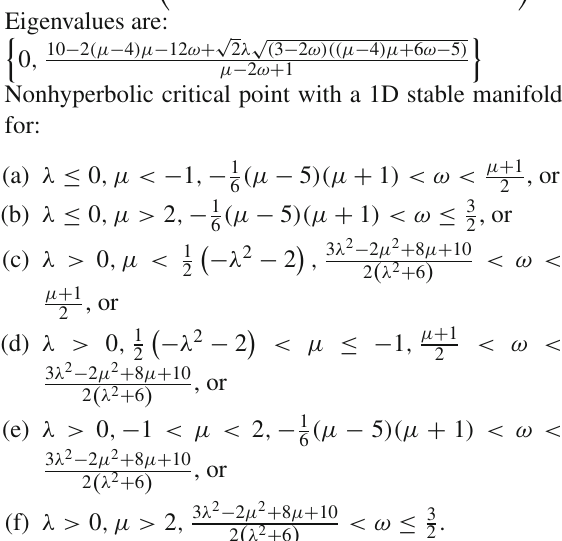
Fig. 2 Stability of A − for a ω = 1, and for b ω = 0. For parameters in the red region (left graph of each panel) A − is a source and for parameters in the blue region (right graph of each panel) it is a